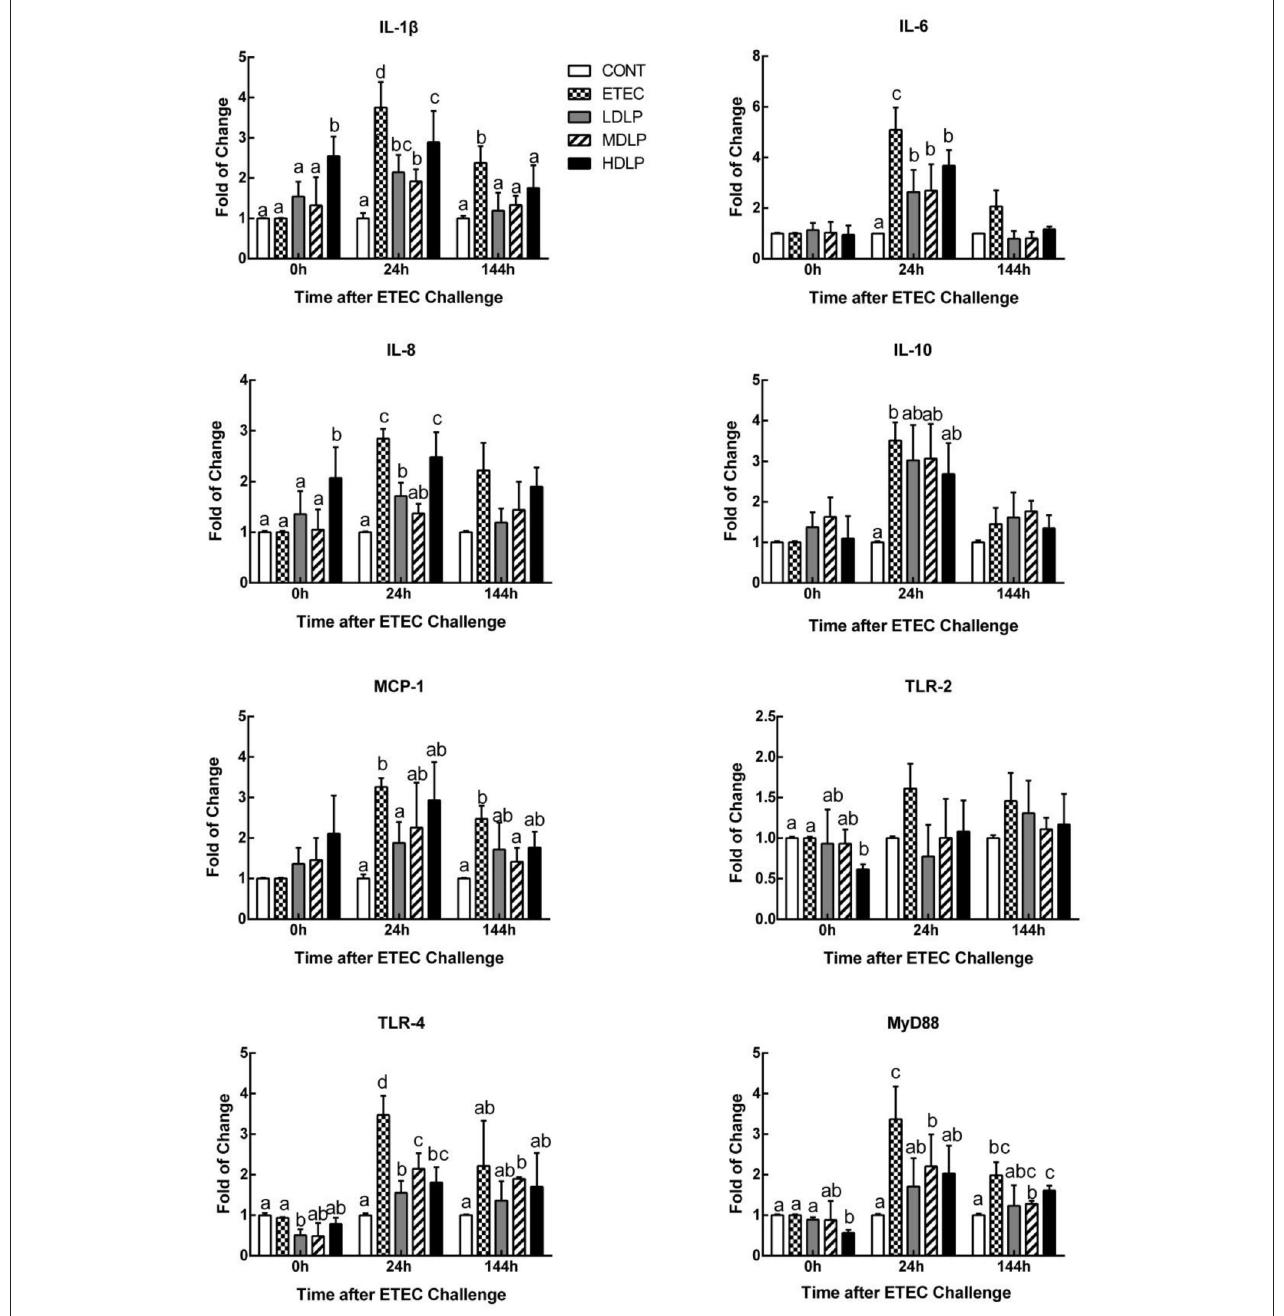
FIGURE 6 | Dose effect of Lactobacillus plantarum on cytokines and Toll-like receptor mRNA expression in jejunum of mice during pre- and post-challenge periods. CONT, control group, treatment with PBS at all period; ETEC, negative group, oral challenge with ETEC on day 15; LDLP, low dose (5.0 × 10 8 cfu mL − 1 )